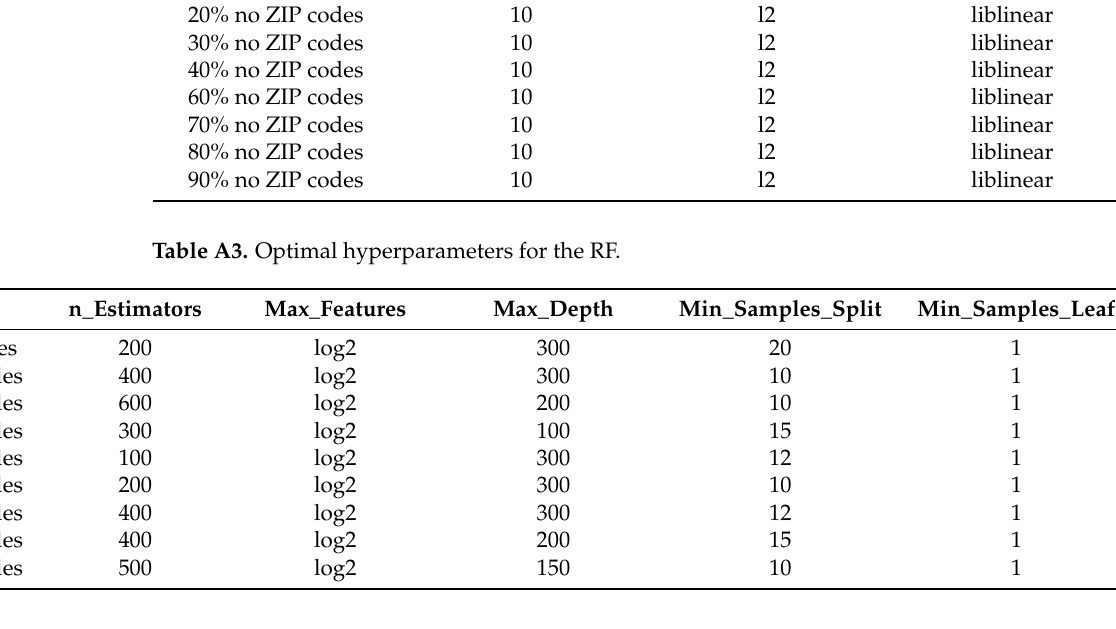
Table A4. Optimal hyperparameters for the